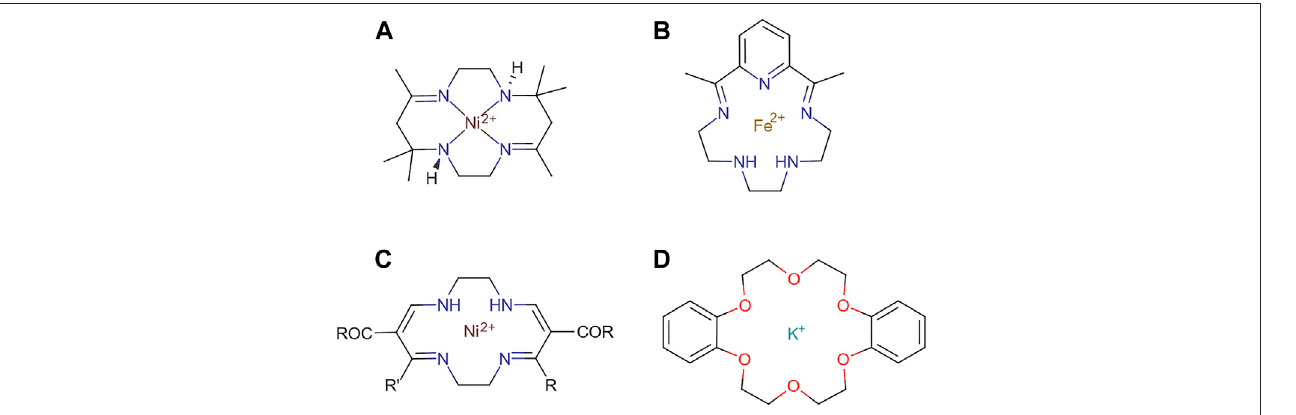
FIGURE 9 | Schematic representations of the pioneering examples of molecules forming the building blocks of systems with supramolecular interactions reported by (A) Curtis, (B) Busch, (C) Jäger, and (D) Pederson.